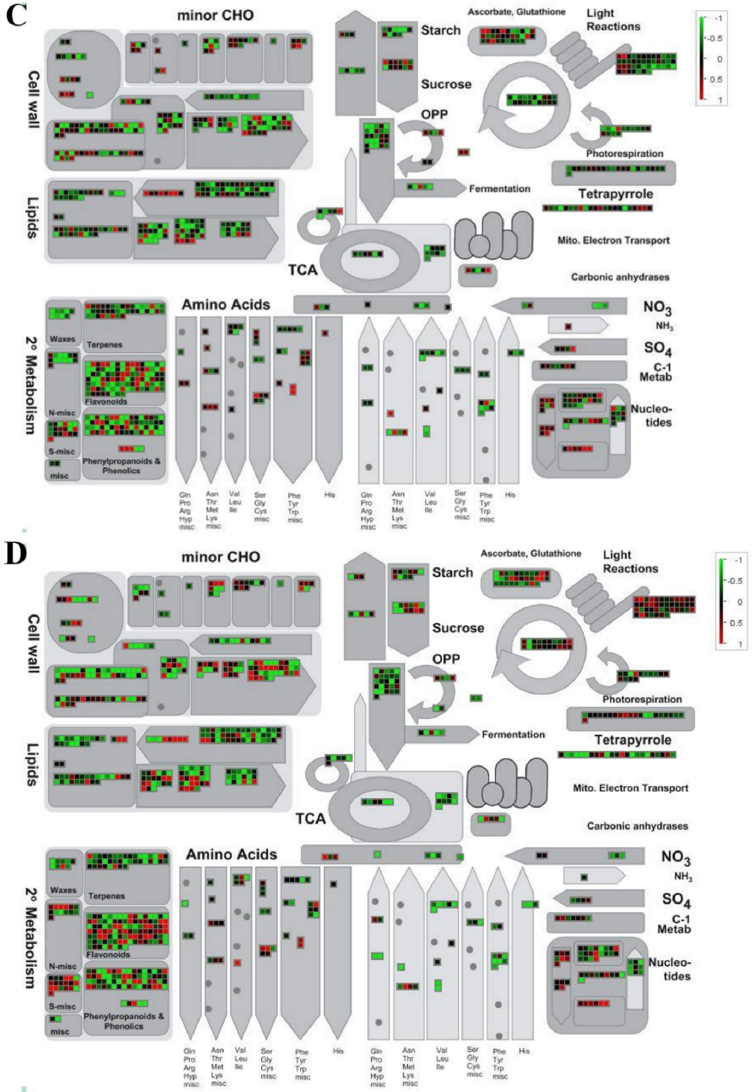
Figure 6. Clustering pattern of DEGs generated using the MapMan tool. ( A ) Biological regulation of DEGs in MM_E vs. CI_E. ( B ) Biological regulation of DEGs in MM_M vs. CI_M. ( C ) Metabolic regulation of DEGs in MM_E vs. CI_E. ( D ) Metabolic regulation of DEGs in MM_M vs.